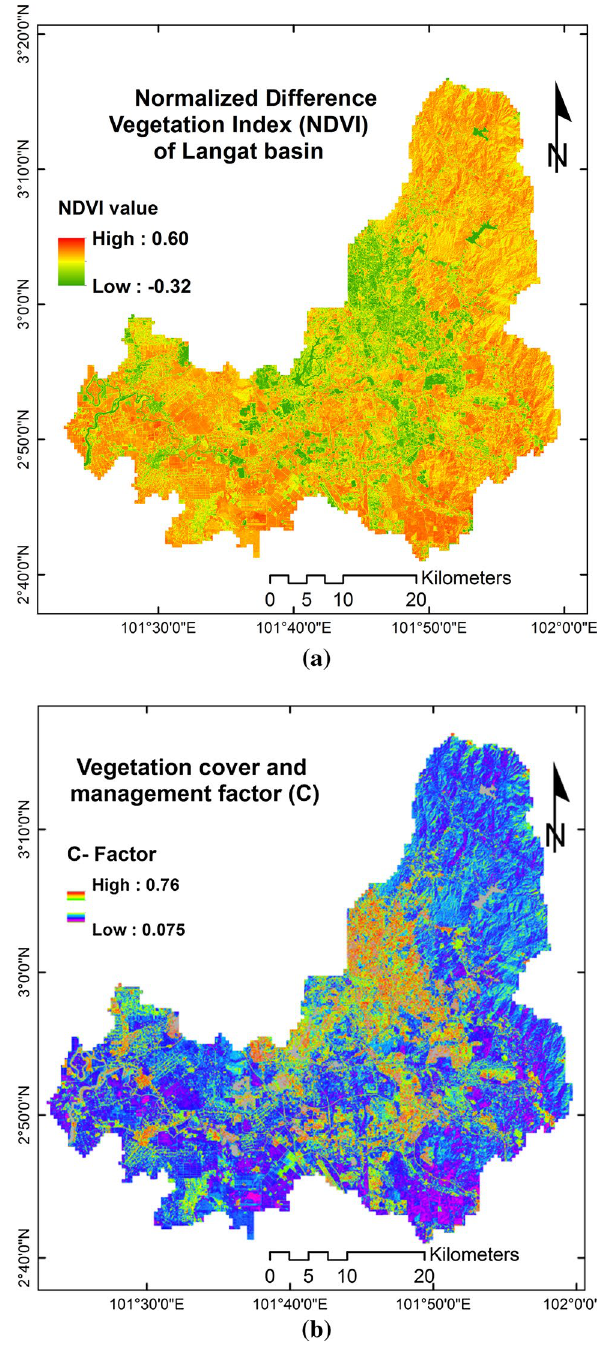
Fig. 7 Normalized difference vegetation index (NDVI) map ( a ) and vegetation cover and management factor (C) map ( b ) of the study